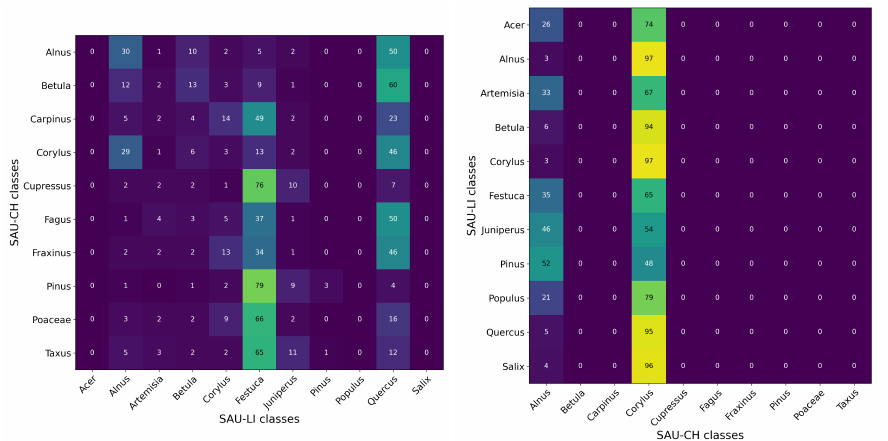
Figure 10. Left: Confusion matrix created on the test set from the SAU-CH dataset with combined model trained on the training set from SAU-LI. Right: Confusion matrix created on the test set from the SAU-LI dataset with model trained on the training set from SAU-CH. Values are percentages.